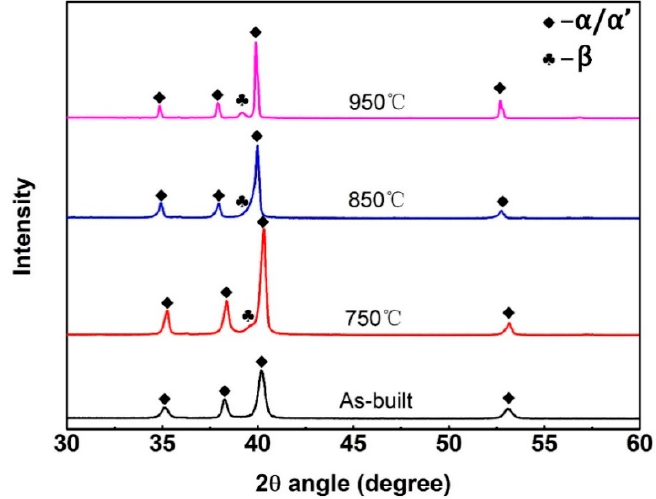
Figure 7. XRD pattern of the porous Ti64 heat treated under different temperatures.